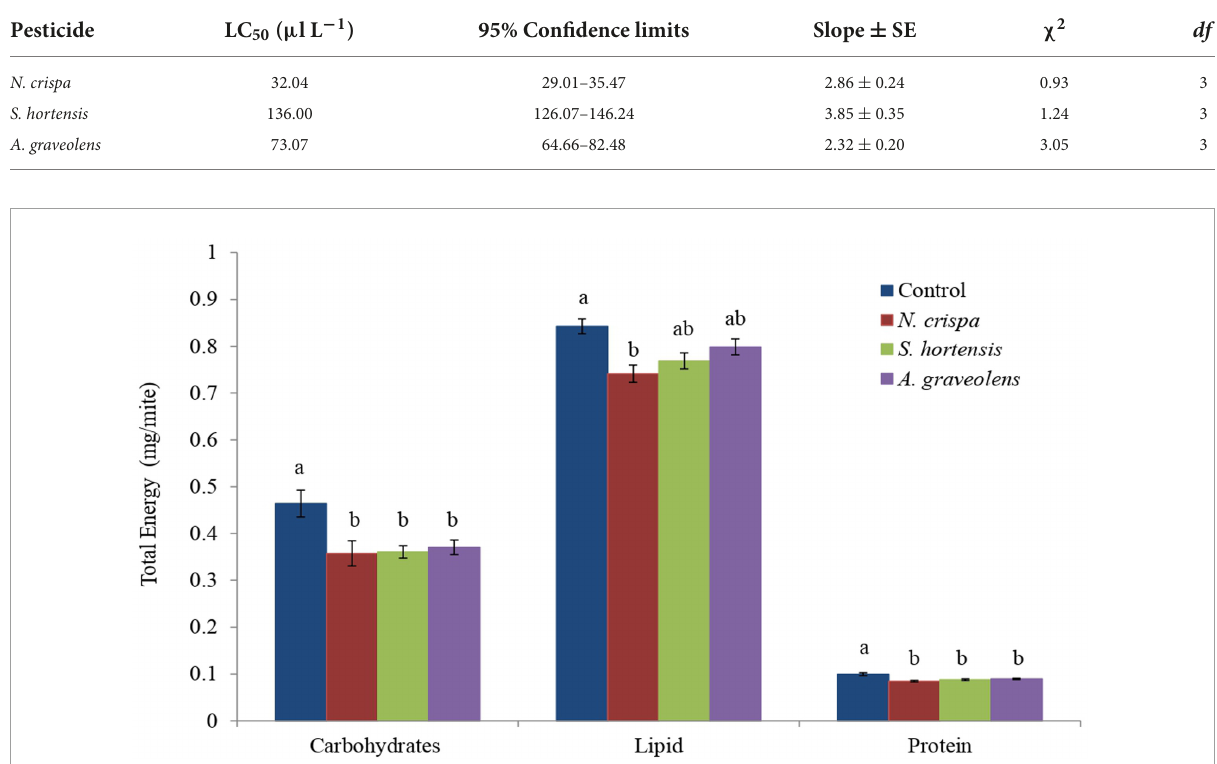
FIGURE2 Total energy content (mean ± SE) of the carbohydrate, lipid, and protein reserves of A. swirskii females exposed to N. crispa , S. hortensis , and A. graveolens oils. Different letters indicate significant differences between treatments based on Tukey’s test ( P < 0.05).